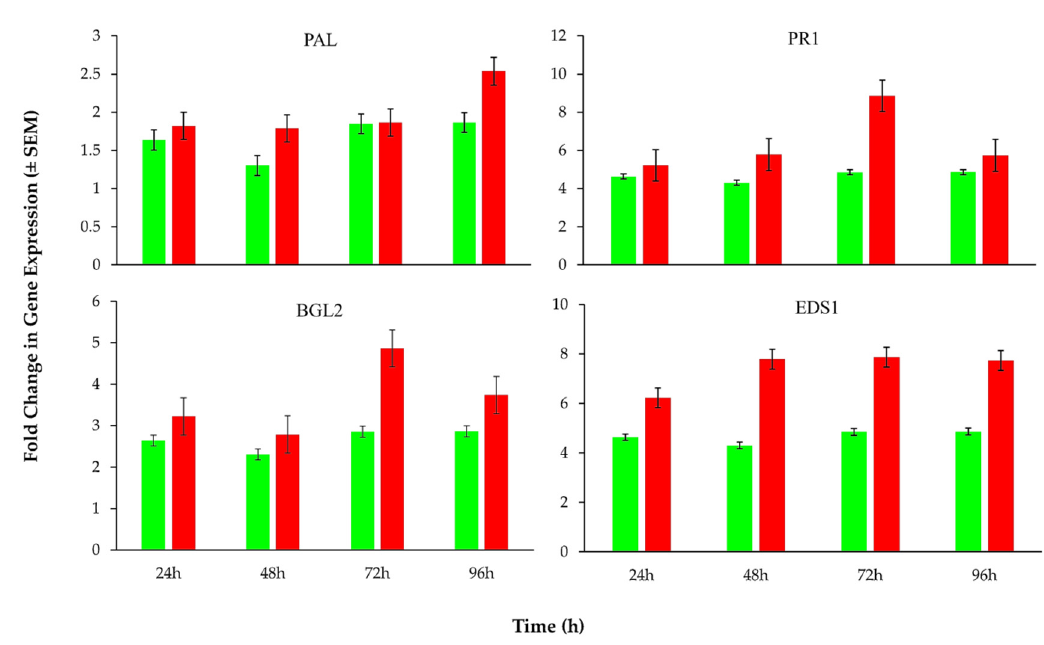
Figure 4. Expression levels of key genes potentially linked to the salicylic acid (SA)-associated plant defense pathways determined at different post-treatment time intervals (sample size n = 9 for each treatment). Green and red columns represent the results for buffer-treated (control) and protein-treated plants, respectively.